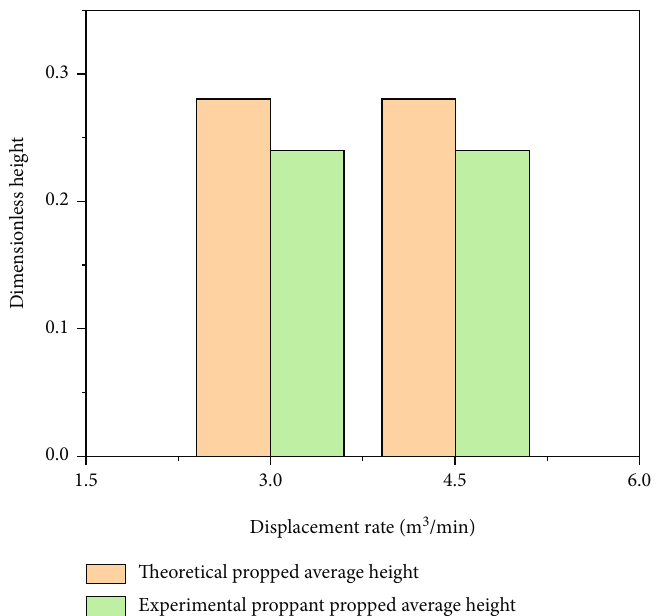
Theoretical propped average height Experimental proppant propped average Figure 3: Comparison of di ff erent displacement rate placement results.